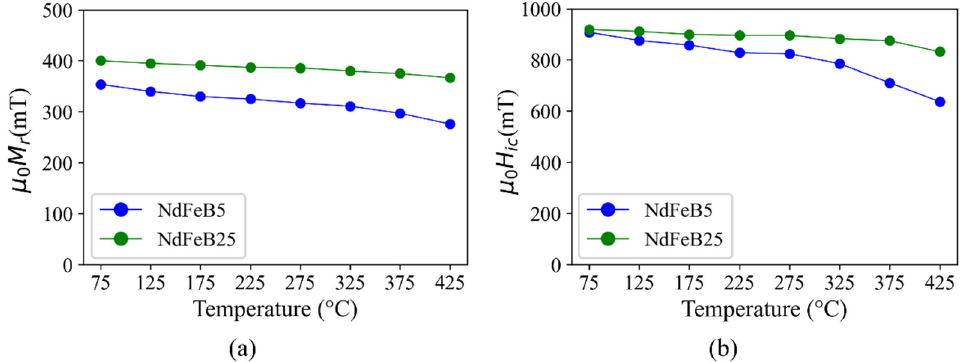
Figure 8. Comparison of irreversible degradation of ( a ) remanence and ( b ) intrinsic coercivity of NdFeB5 and NdFeB25 micromagnets after annealing at different temperatures. For each data point the sample is annealed in air for 1 h, followed by a cool down and re-magnetization at 2 T.